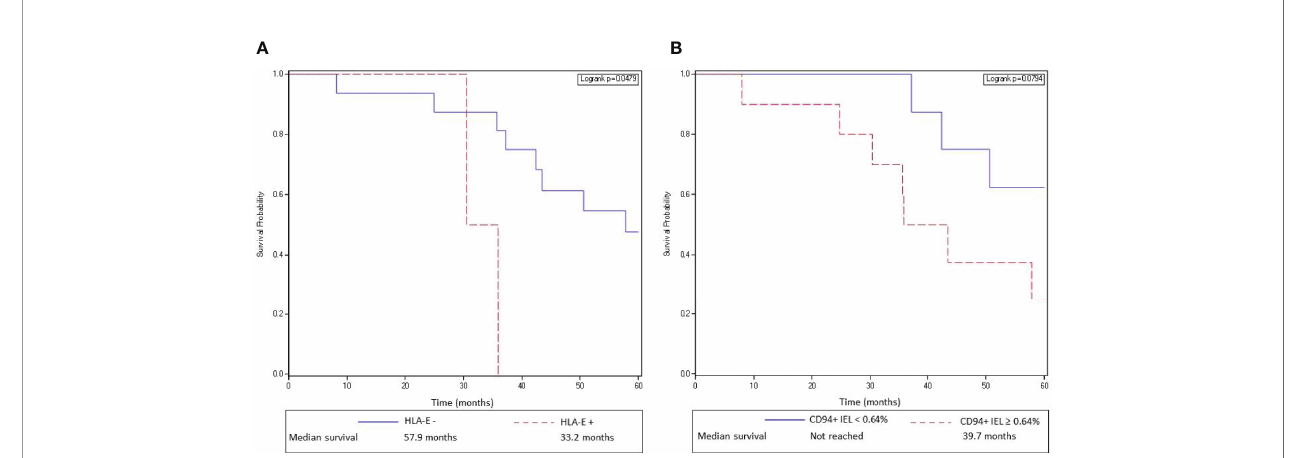
FIGURE 5 | HLA-E/ b 2m overexpression by tumor cells and a high density of CD94 + intraepithelial lymphocytes in primary tumors are associated with a poor overall survival in mCRC patients. (A) Kaplan-Meier curves depict overall survival of patients with a mCRC without HLA-E/ b 2m overexpression by tumor cells (solid curve) or with HLA-E/ b 2m overexpression by tumor cells (broken curve). (B) Kaplan-Meier curves depict overall survival of patients with a mCRC containing a high (broken curve) or a low (solid line) density of CD94 + intraepithelial lymphocytes (second